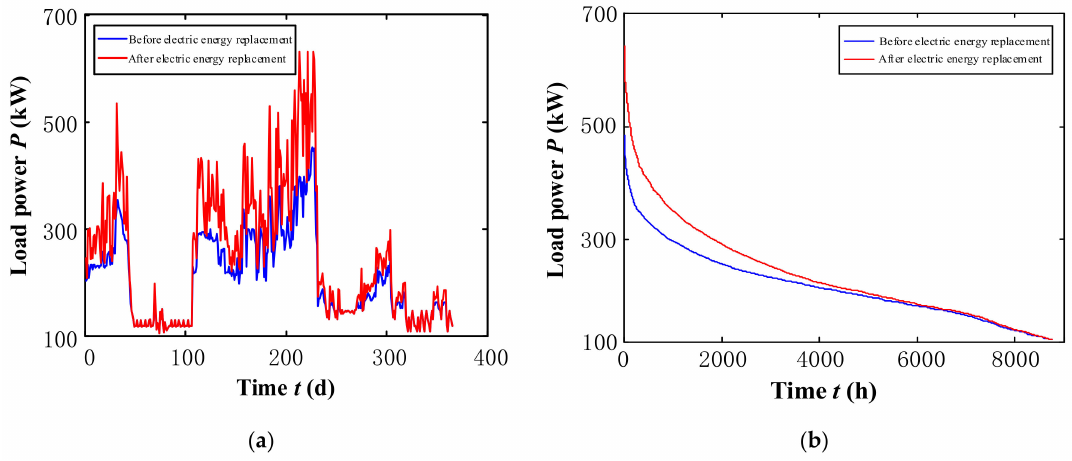
Figure 2. Annual load curve of hot pot load. ( a ) annual maximum load curve; ( b ) annual continuous load